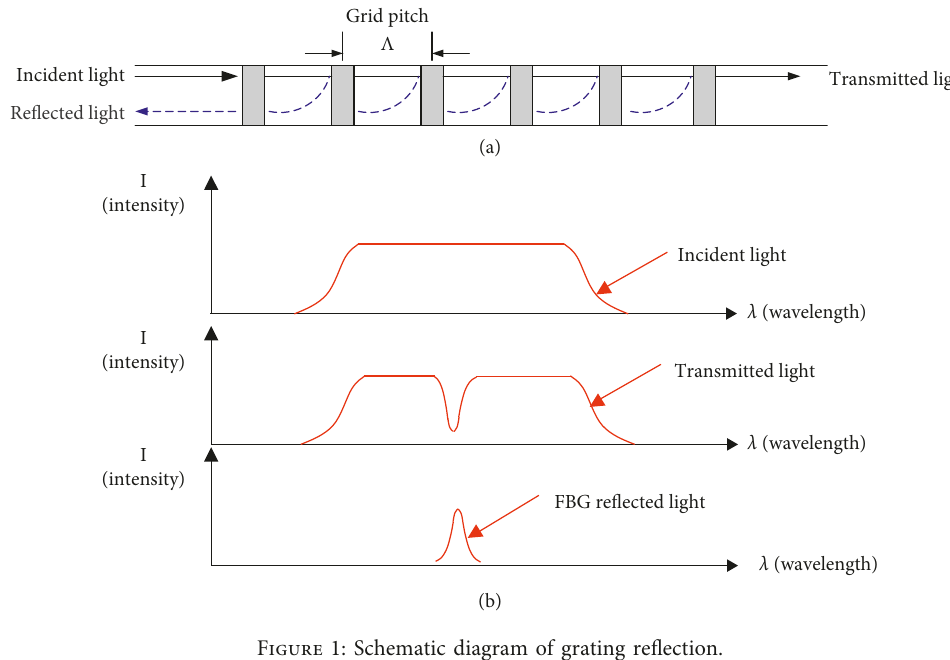
Figure 1: Schematic diagram of grating reflection.